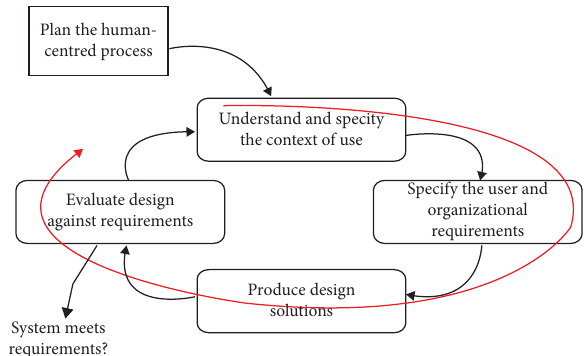
Figure 1: Human-centred design thinking